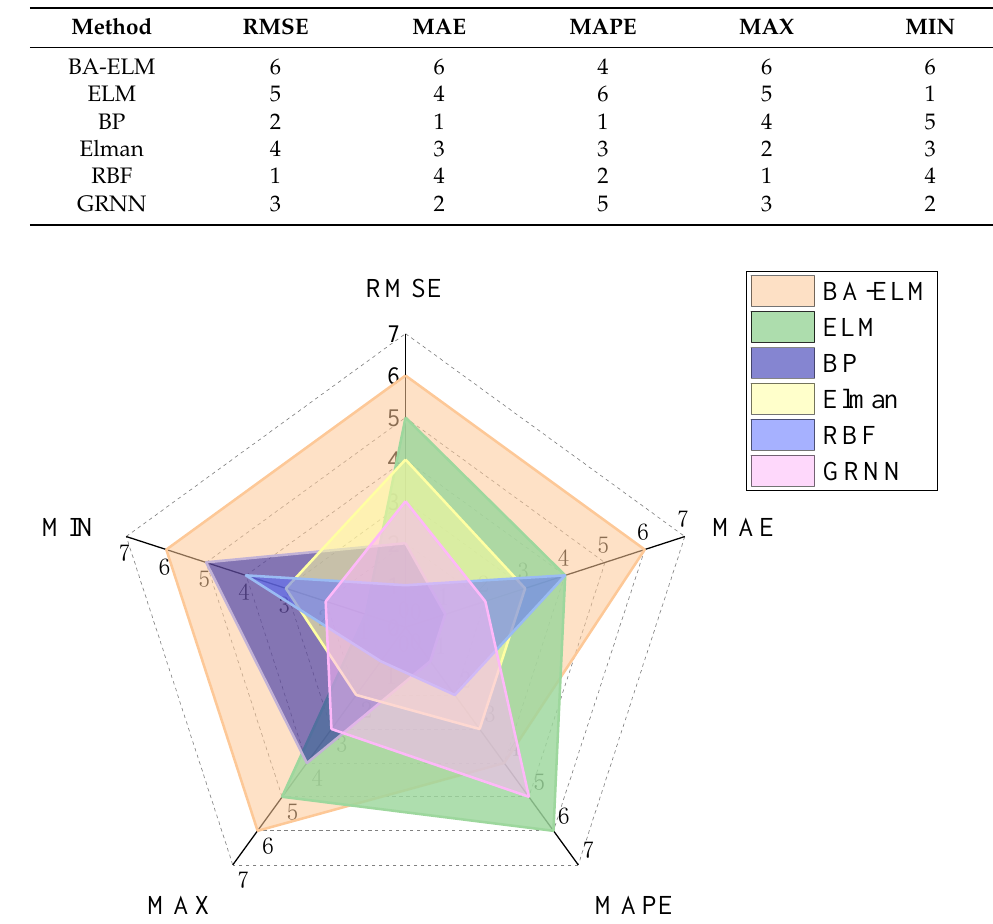
Table 8. Scores of the six models.